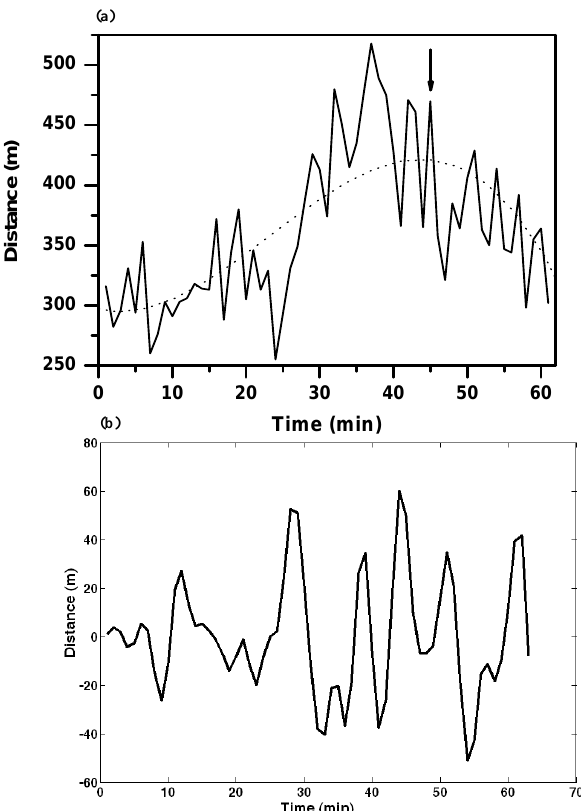
Fig. 2. (a) Time profile of the vertical distance traversed by the balloon in each successive minute computed directly from the radar tracking data as observed on 2 September 2002. The dashed line shows 3rd order polynomial fit. The arrow in the figure represents the altitude of cold point tropopause (b) The detrended and high- pass filtered data of panel (a) (see text).